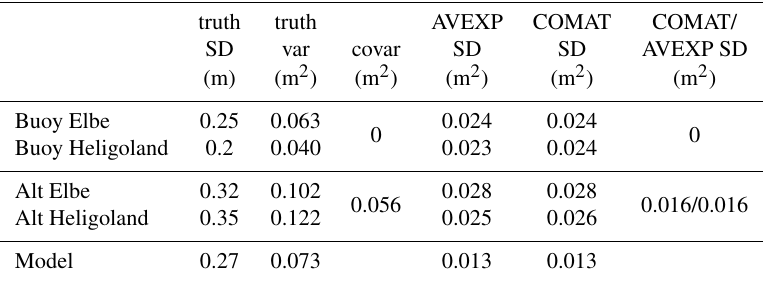
Table 3. Parameters used for the Monte Carlo simulations in Sect. 2.5. The first two columns refer to the stochastic wave height error standard deviation (SD) and variance (var) assumed for the considered data sources. The third column gives the assumed error cross covariance (covar) values for the two altimeter measurements and the two buoy data sets. The fourth column is the error standard deviation of the estimator for the observation error variances obtained by averaging over 1000 estimation experiments (AVEXP approach). The values in column five refer to the same estimation errors, but derived by application of the method described in Sect. 2.1 (COMAT approach). The last column gives the COMAT and AVEXP standard deviations for the covariance estimation errors.